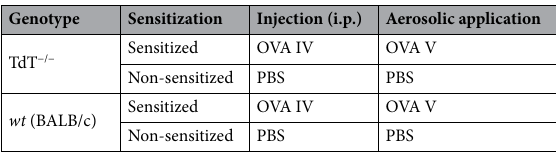
Table 1. Model of allergic airway